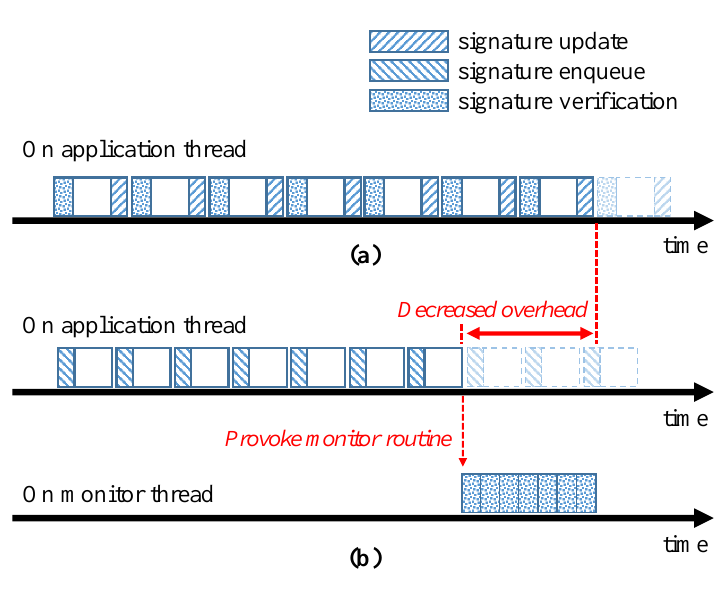
Figure 4. ( a ) Typical non-SSCFM scheme; and ( b ) the proposed SSCFM